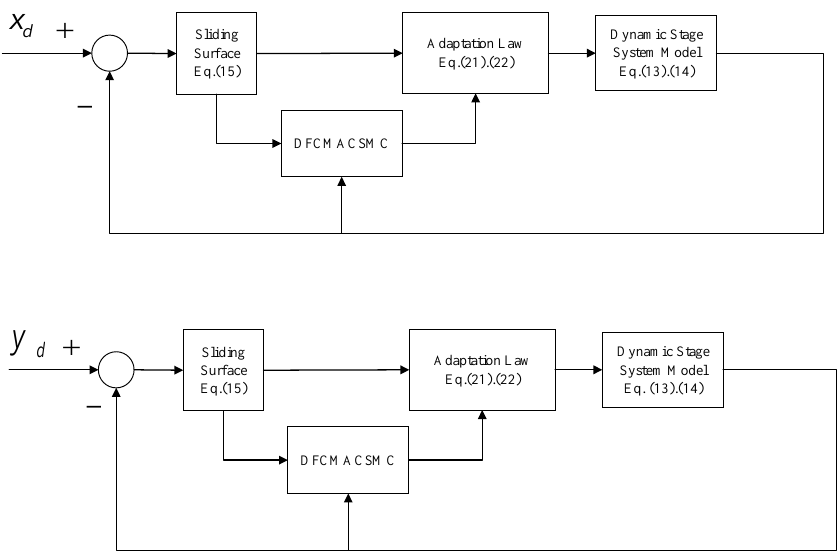
Figure 5. The overall scheme of the DFCMAC sliding mode control system.